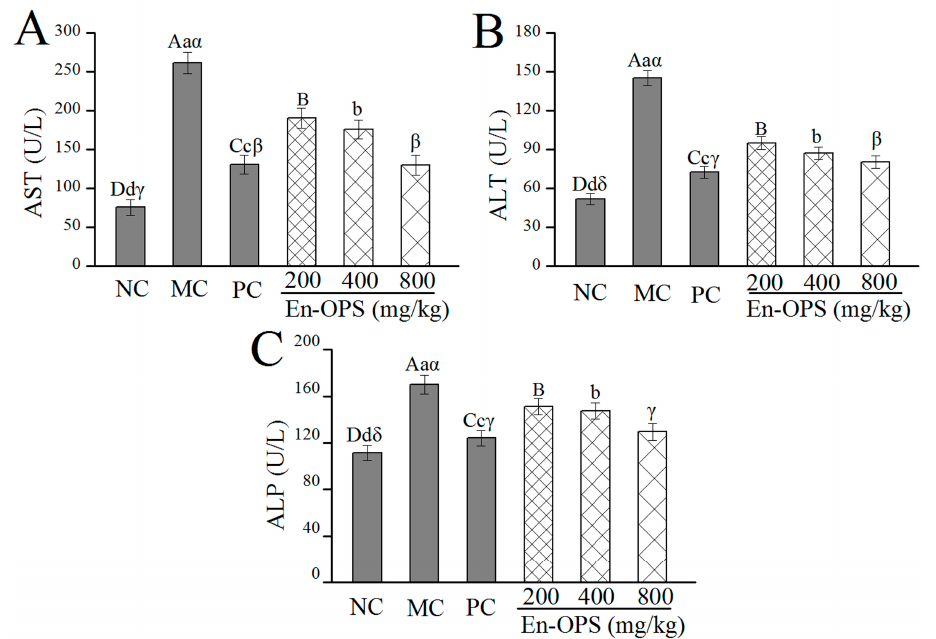
Figure 2. Effects of En-OPS on the enzymic activities in serum of mice. ( A ) aspertate aminotransferase; ( B ) alamine aminotransferase; and ( C ) alkaline phosphatase. The values were reported as the mean ± S.D. of 10 mice per group. Bars with different letters were significantly different ( p < 0.05). The statistical significance of the differences between the groups were analyzed using Tukey’s tests in the software package (SAS 9.3). A value of p < 0.05 was regarded as statistically significant.